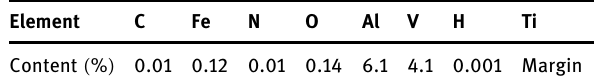
Table 1: Chemical composition of Ti6Al4V